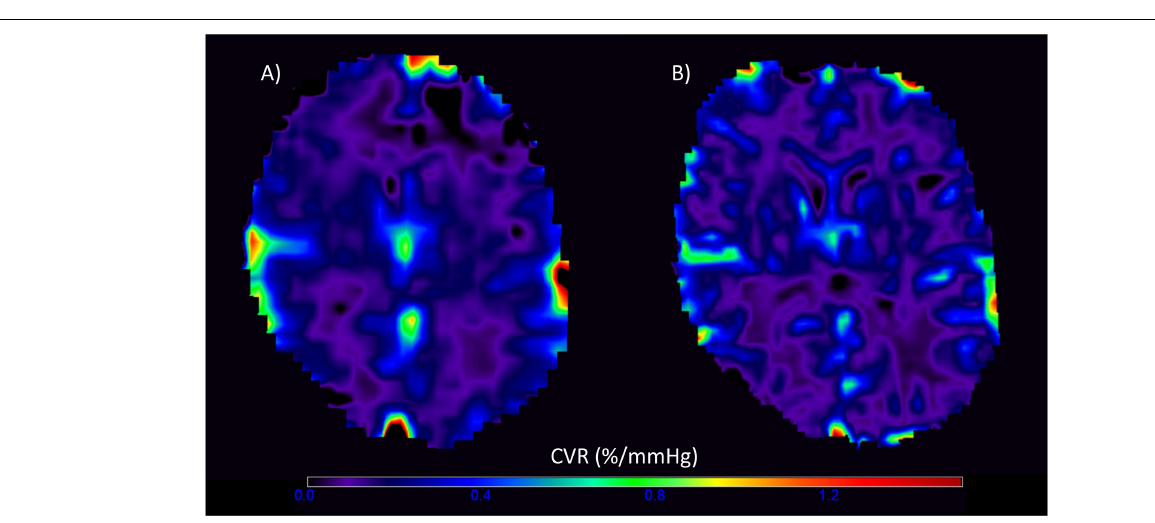
FIGURE 1 | Schematic diagram of the study design and key analysis steps.